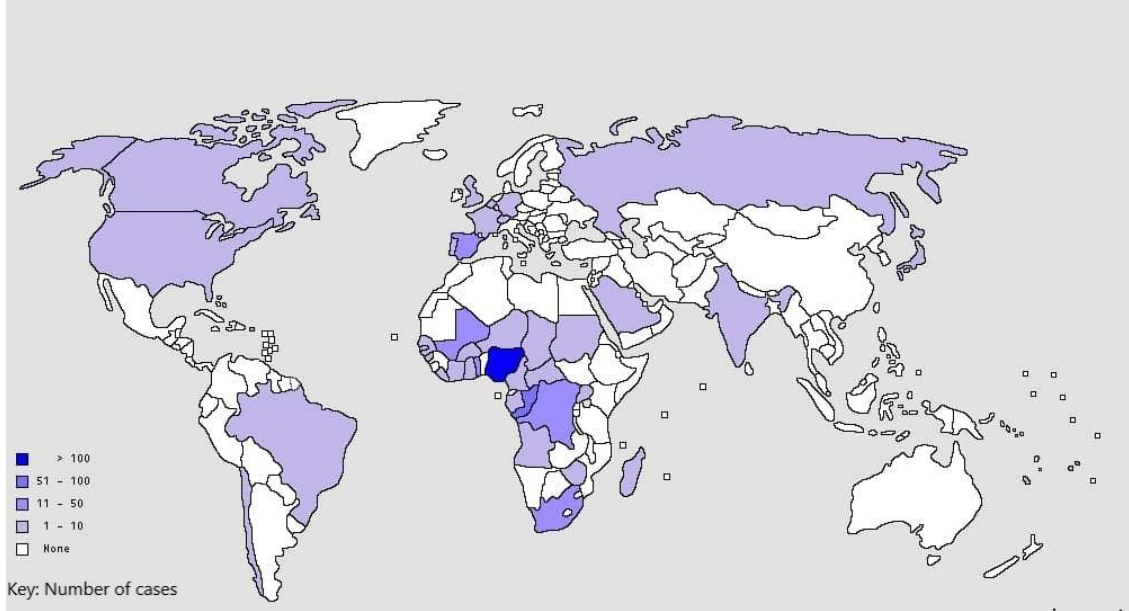
Figure 1 . Locations around the globe with documented cases of Hcd